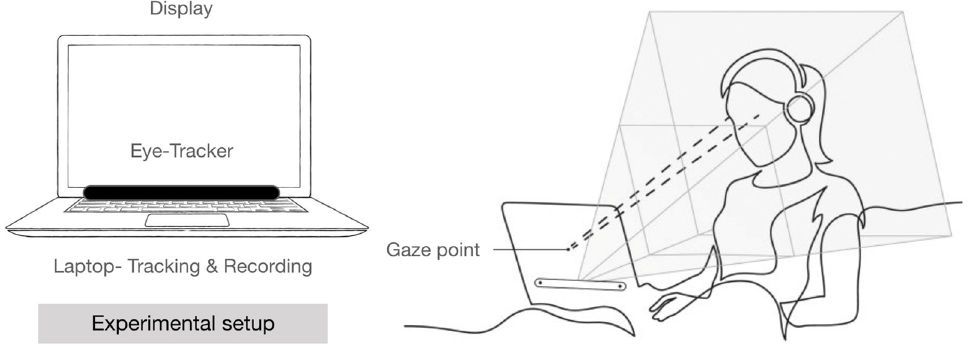
Figure 1. Experimental setup.